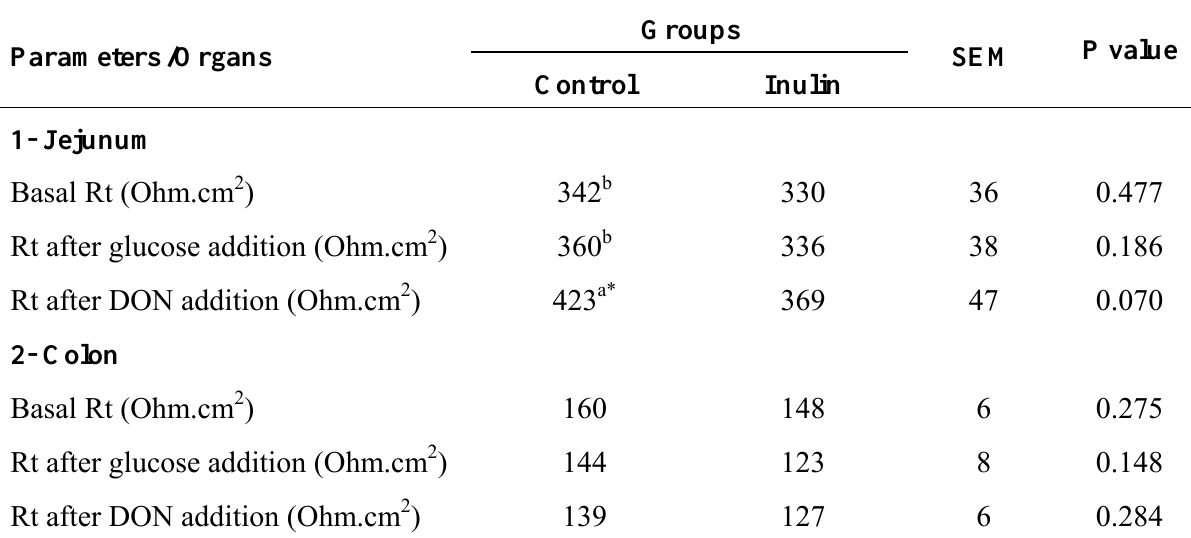
Table 3. The electrical tissue resistance (Rt) in isolated jejunal and colonic mucosa of broilers after addition of glucose and